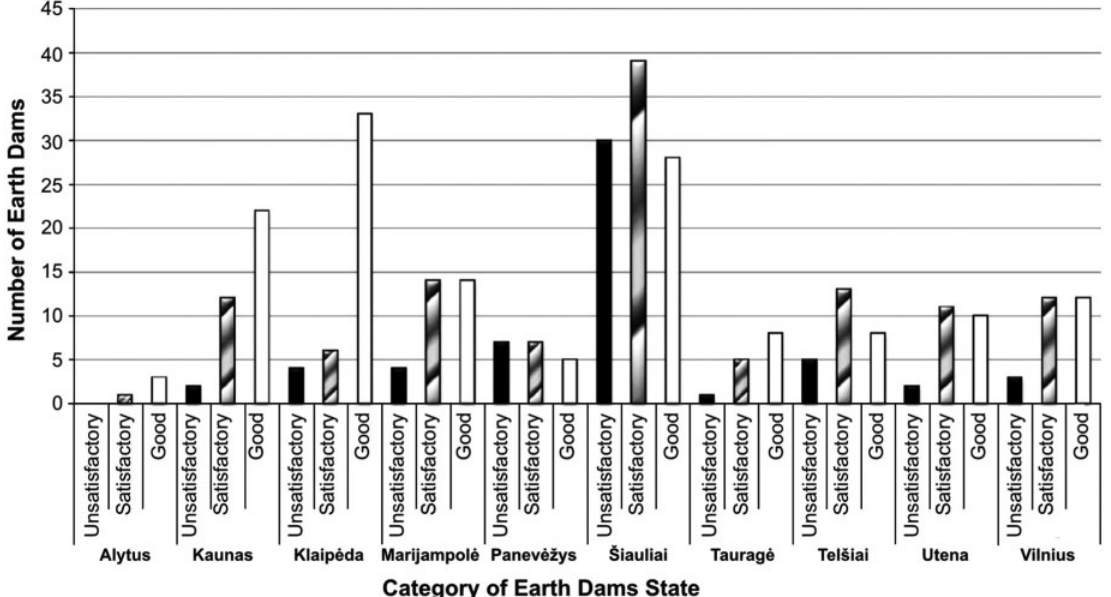
Fig. 1. Distribution of the category of dams’ technical state in 1997 by